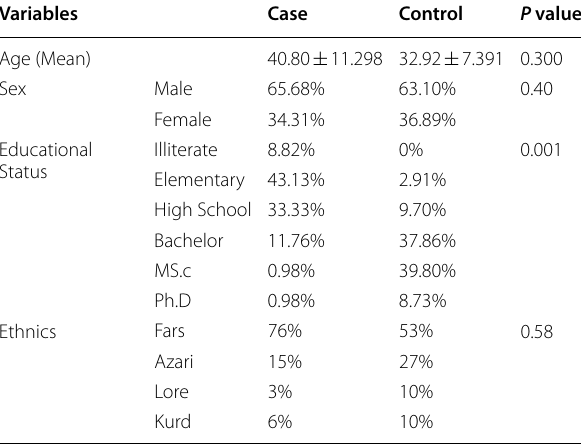
Table 1 Comparison of demographic data between case and control